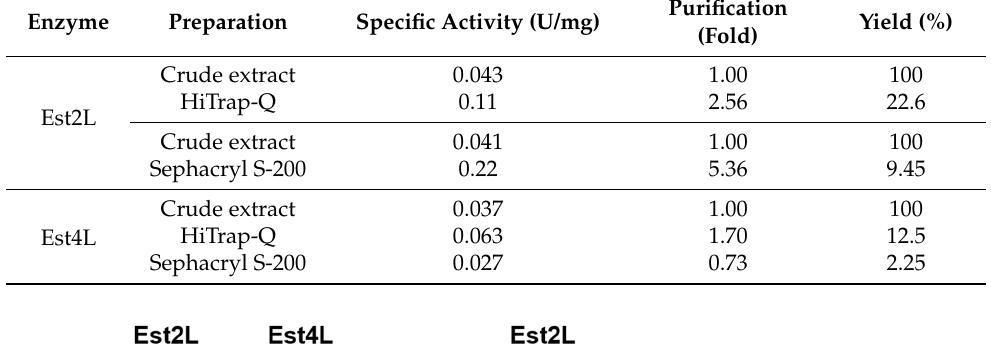
kDa, respectively (Figure 3). Because homogeneous and active enzymes were not obtained, these fractions were used for further study.